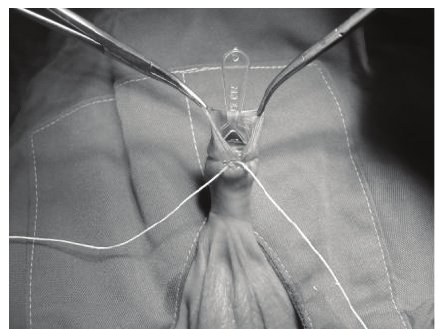
Figure 3: Tying the foreskin over the bell.